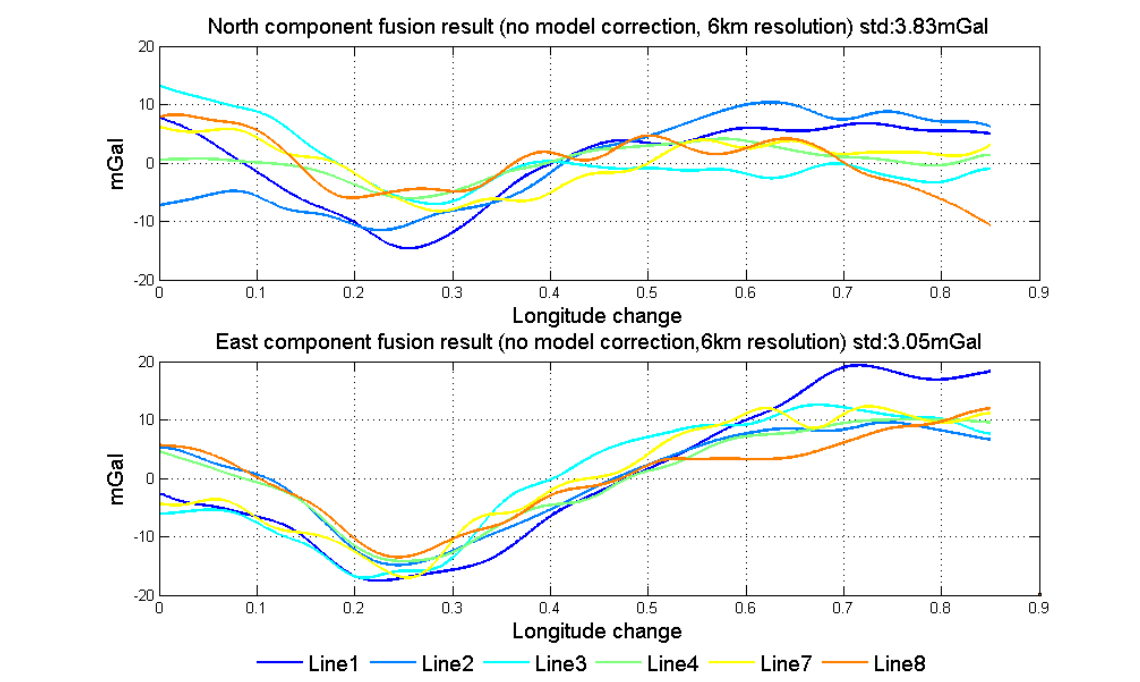
Figure 22. Results in 6 km resolution under the condition of no gravity field model